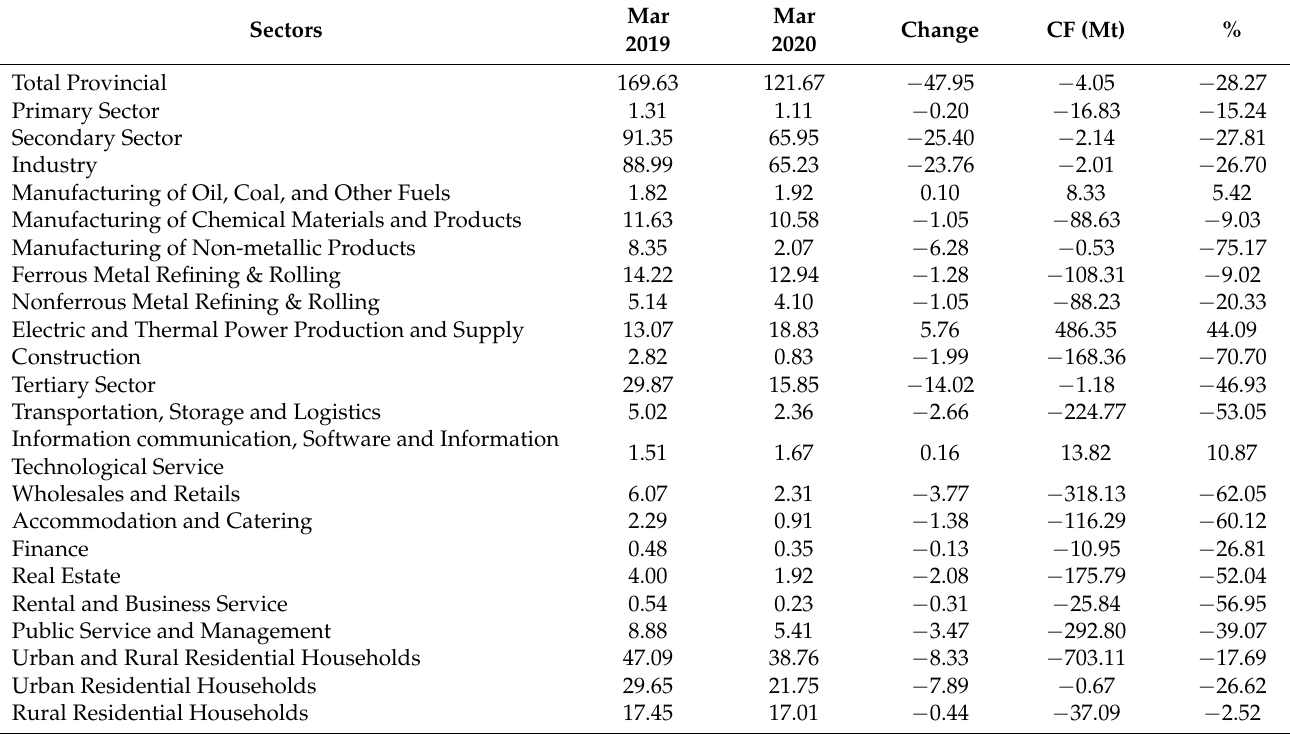
Table 8. Hubei sectoral carbon footprint changes of March 2020 compared to March 2019.